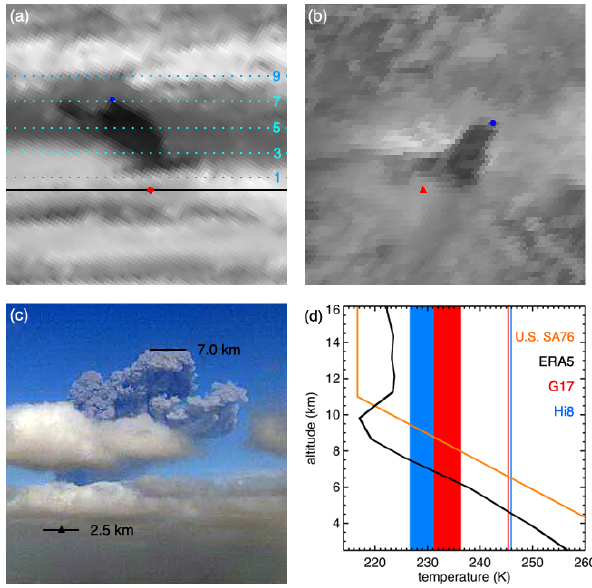
Figure 6. (a) GOES-17 band 2 fixed grid image (8 × magnifica- tion), (b) Himawari-8 band 3 CEReS V20190123 gridded and re- sampled image (0.005 ◦ or ∼ 0.5km resolution, 3 × magnification), and (c) Klyuchi webcam image of the 10 April 2019 eruption of Sheveluch at 03:00UTC. The red diamond/triangle marks the vol- cano base, and the blue dots indicate the same plume top element in the satellite images. In panel (a) , the baseline (solid black) and the odd number isoheights (in km, dotted cyan) are also drawn. In panel (c) , the black triangle denotes the vent. Panel (d) shows the ERA5 temperature profile above the vent (black line), the U.S. Standard Atmosphere 1976 temperature profile (orange line), the GOES-17 and Himawari-8 minimum BT 11 at 03:00UTC (red and blue vertical lines), and the range of the minimum BT 11 between 03:10–04:00UTC (red and blue shaded areas).